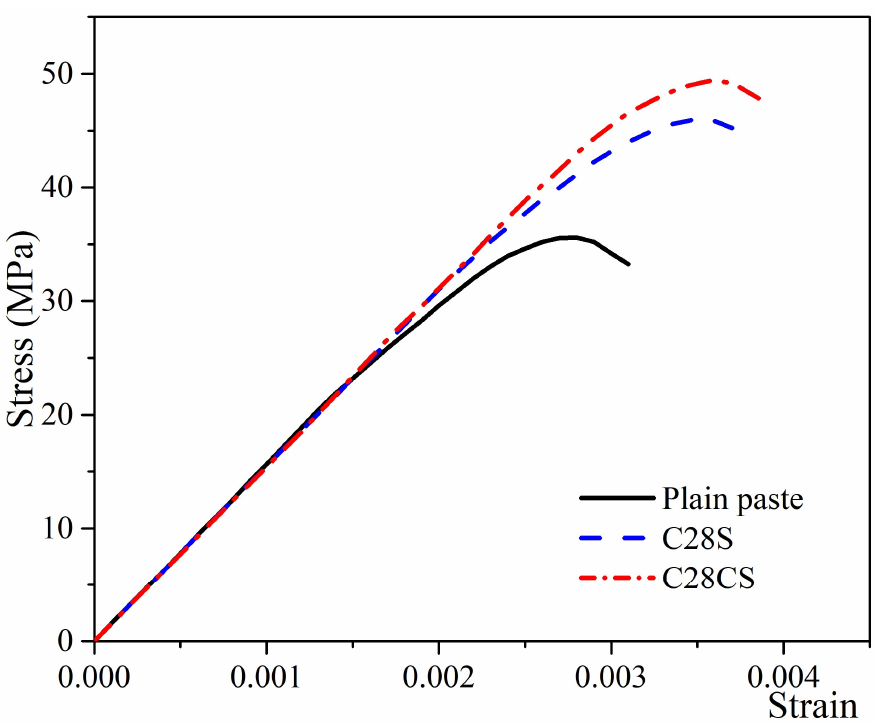
Figure 5. Constitutive curves of hardened plain and modified cement pastes. Table 7. The 28-day toughness (J/m 3 Table 6. Effectiveness of TEOS/PVP NFs, CNT-TEOS/PVP NFs, N66 NFs, and CNT-N66 NFs on mechanical properties of cement pastes (increase in % compared with parameters of control sam- ples).